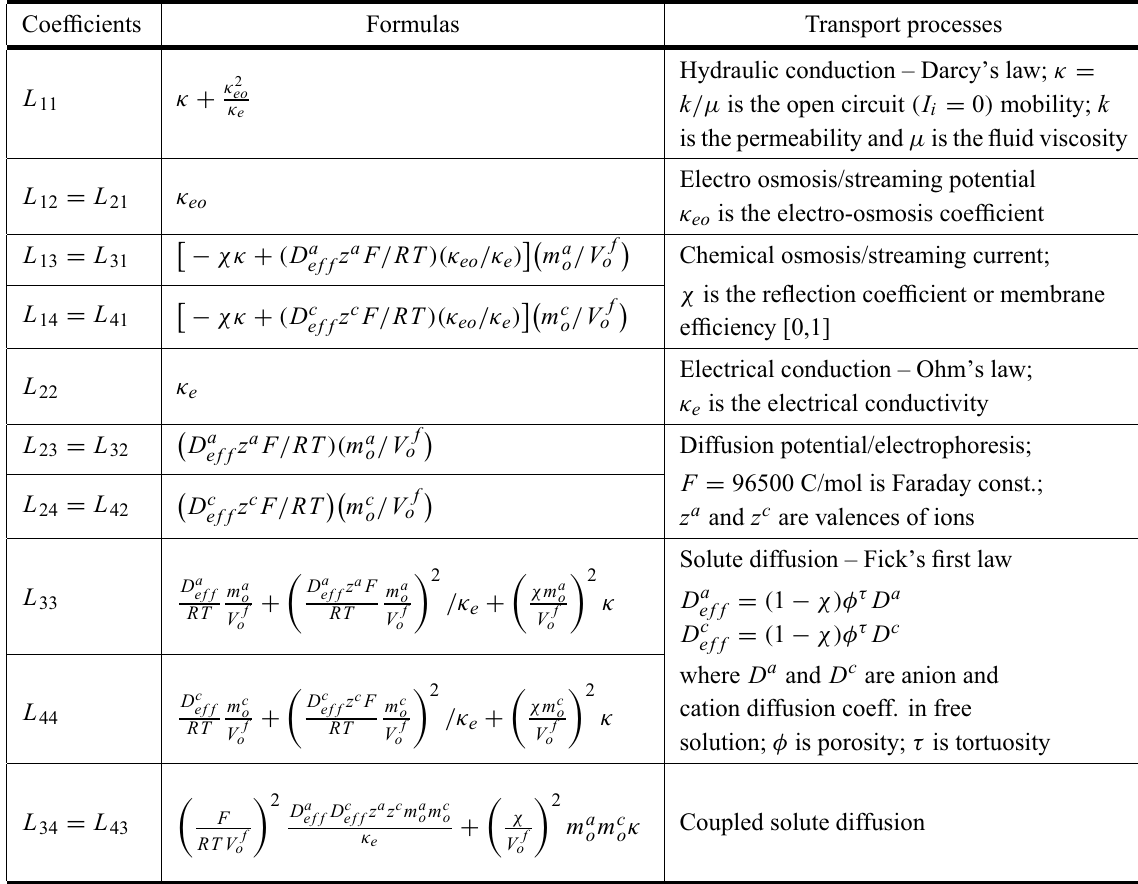
Coupled electrokinetic transport